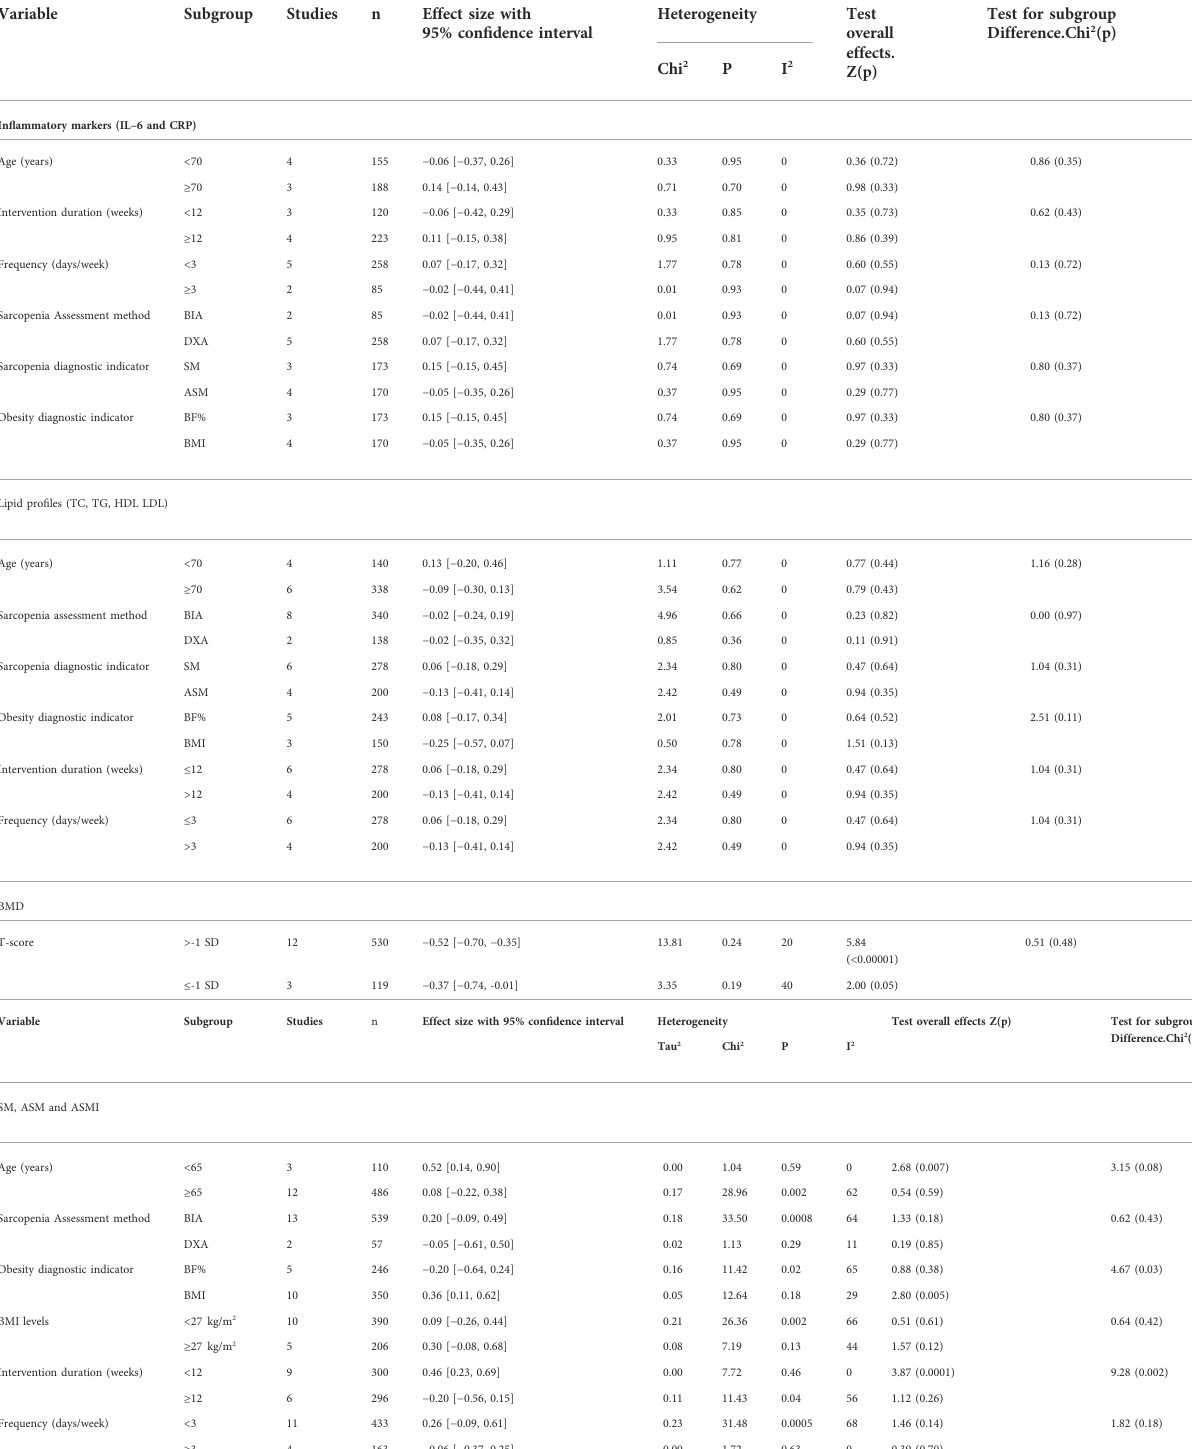
TABLE 5 In fl uence of moderator variables in the effect of physical activity on in fl ammatory markers, lipid pro fi les, BMD and muscle mass.